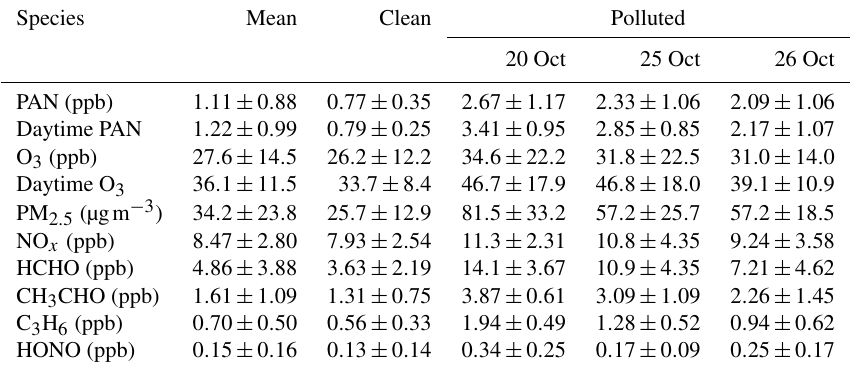
Table 1. Statistical results of concentrations for PAN (ppb), PM 2 . 5 (µgm − 3 ), O 3 (ppb), NO x (ppb), HCHO (ppb), CH 3 CHO (ppb), C 3 H 6 (ppb), and HONO (ppb), on average, during clean days and polluted days. The clean days represent the time that excludes the polluted days (20 and 25–26 October), and the daytime denotes 08:00–19:00LT. Species Mean Clean